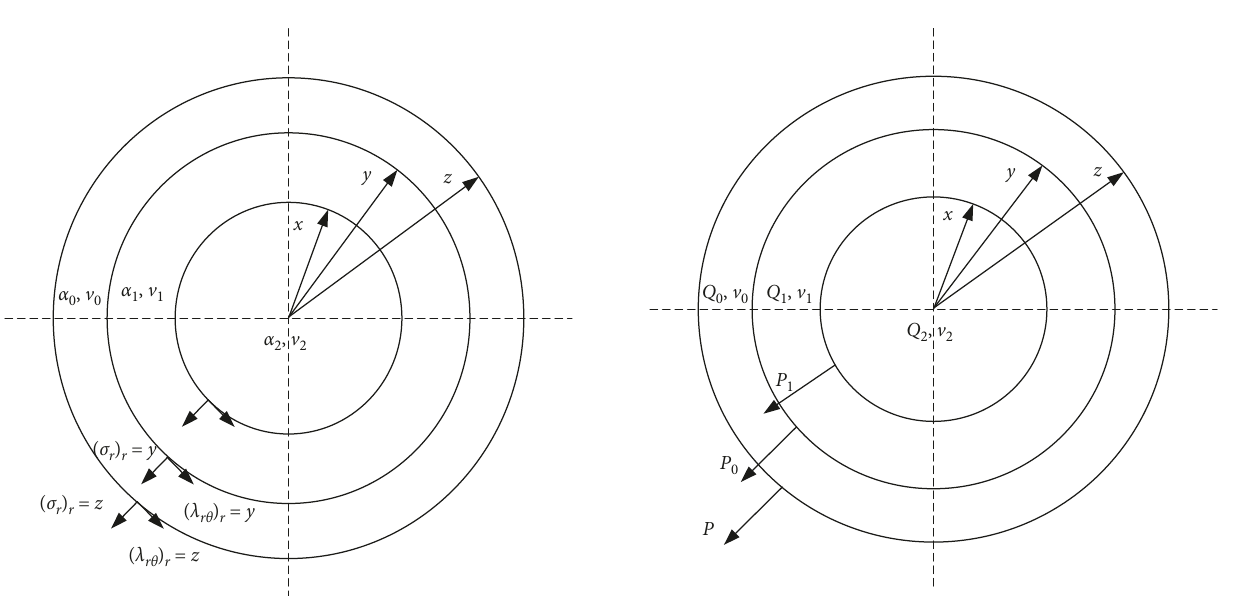
Figure 6: Shear modulus prediction meso-level model.